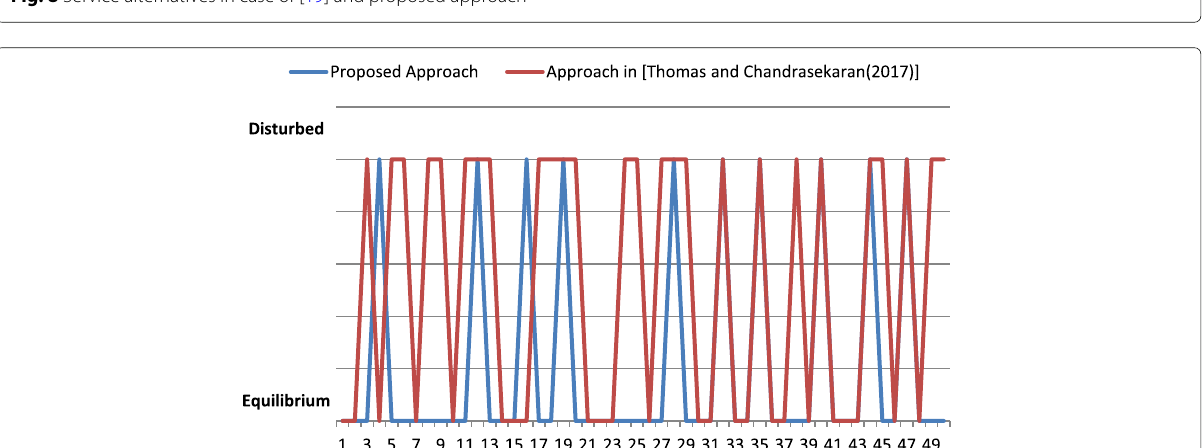
Fig. 8 Service alternatives in case of [19] and proposed approach